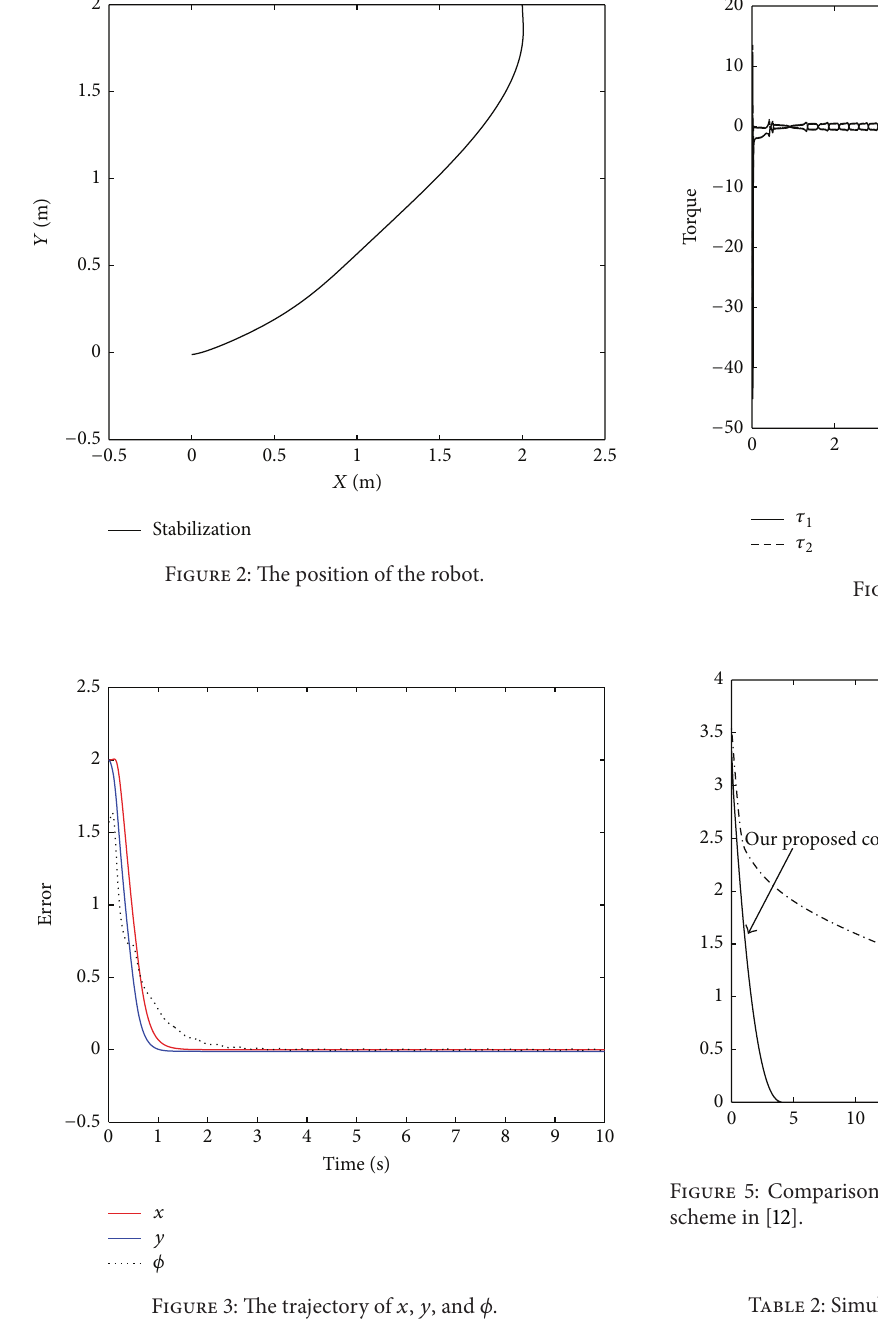
Table 2: Simulation parameters of mobile